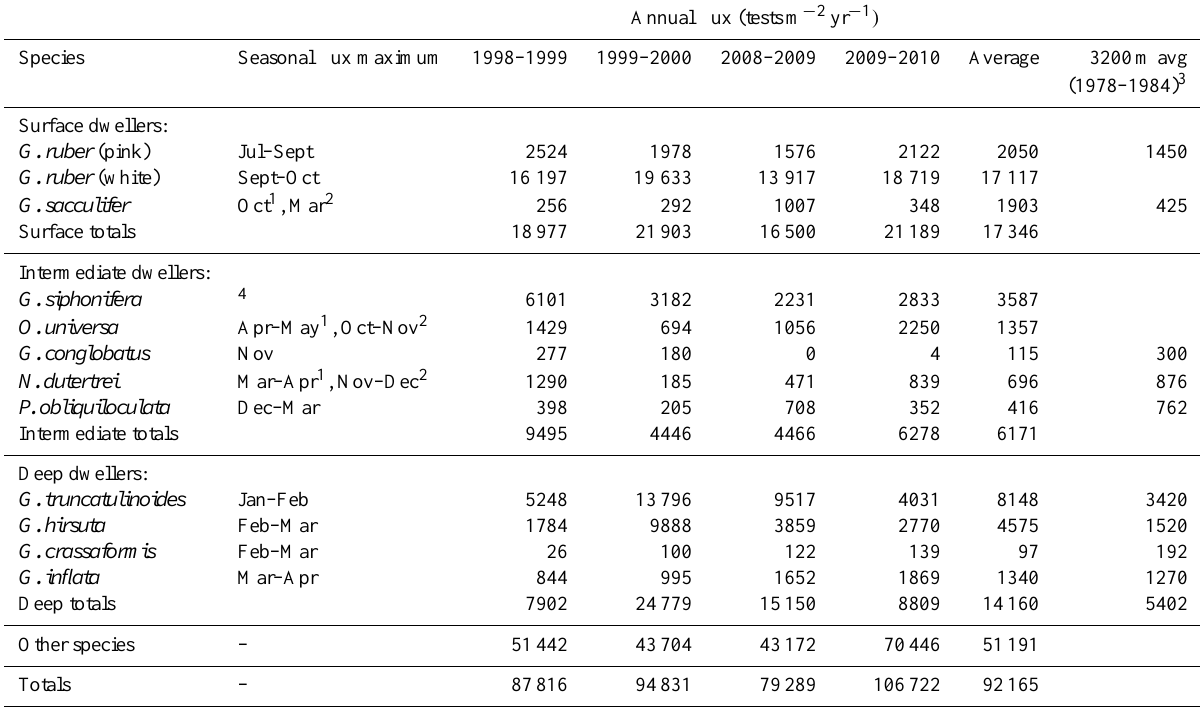
Table 1. Annual fluxes for planktonic foraminifera species at 1500m depth in 1998–1999, 1999–2000, 2008–2009 and 2009–2010 and the 4-year averages. Fluxes were calculated from the sum of bi-weekly averages between July and June for each year and converted to testsm − 2 yr − 1 . Species are listed according to their estimated depth